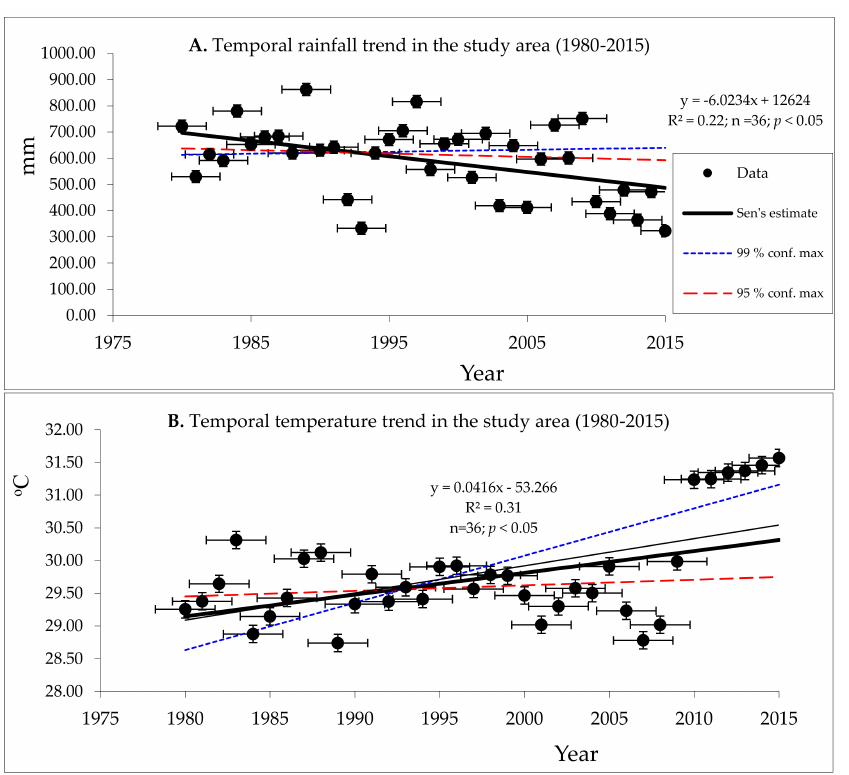
Figure 3. Production trend of the major crops in the sampled villages. Source: Adapted from Mkonda and He [17].